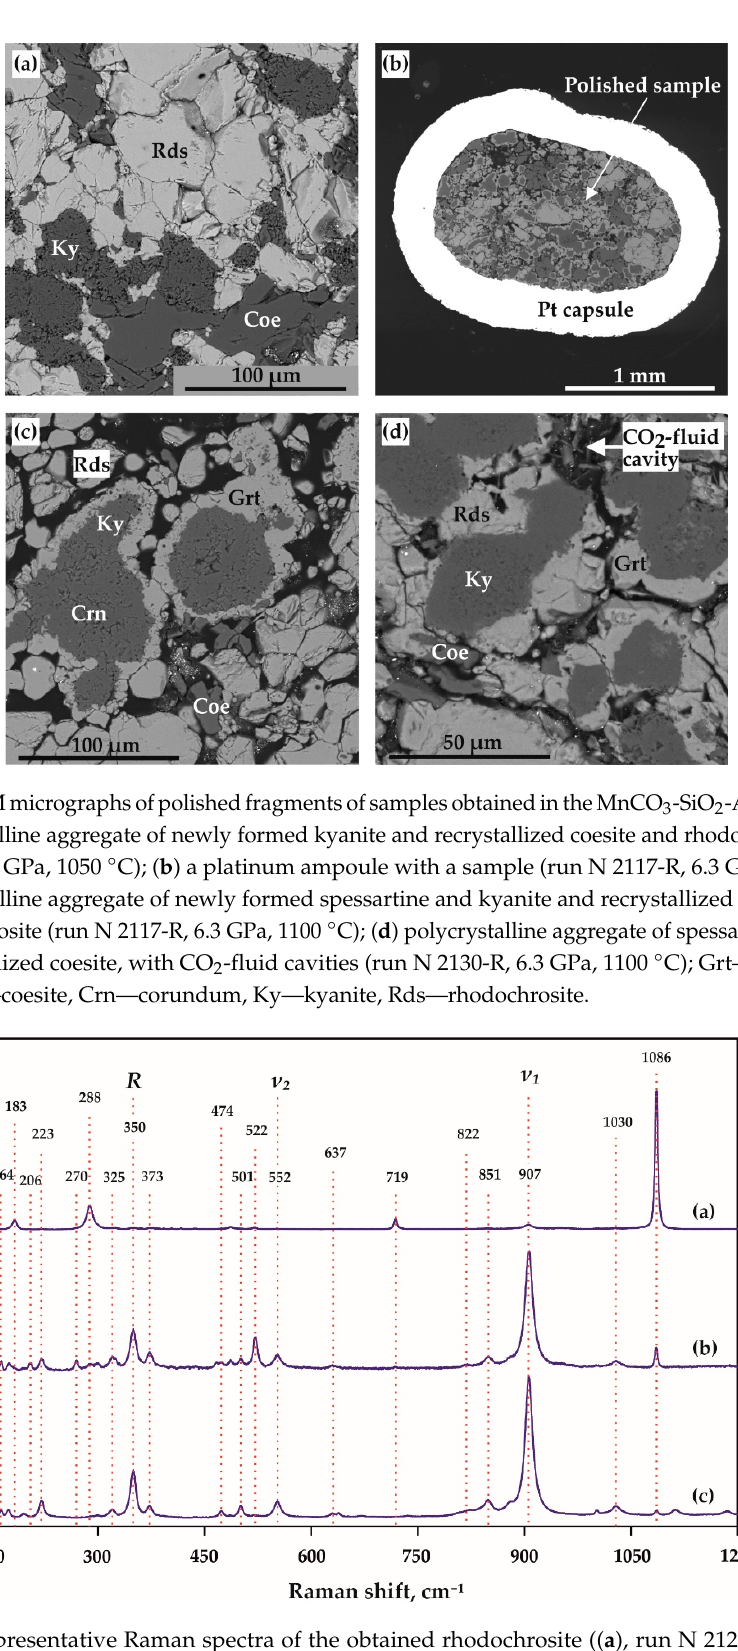
Figure 4. Representative Raman spectra of the obtained rhodochrosite (( a ), run N 2129-R, 6.3 GPa, 1050 °C) and spessartine (( b ) run N 1744-R, 3.0 GPa, 950 °C; ( c ) run N 2117-R, 6.3 GPa, 1100 °C). R, υ 1 , υ 2 —Modes, related to librational (R(SiO 4 ) 4 − ), internal bending ((Si-O) bend , υ 2 ), and stretching ((Si-O)str, υ 1 ) vibrations of the SiO 4 tetrahedron, respectively.